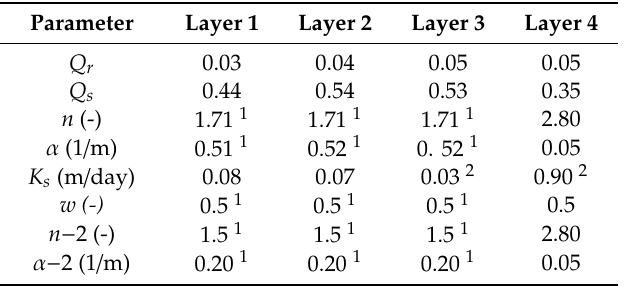
Figure 4. Comparison of the calculated (lines) and observed (open circles) pressure heads at different depths (cm b.g.l.). The −30 cm observation point belongs to Layer 2, while -60 cm and -90 cm observation points belong to Layer 3. Rainfall and irrigation events (blue line) are also plotted. Table 3. Flow parameters obtained by inverse modeling in the STD and No-till+CMP experimental plots.